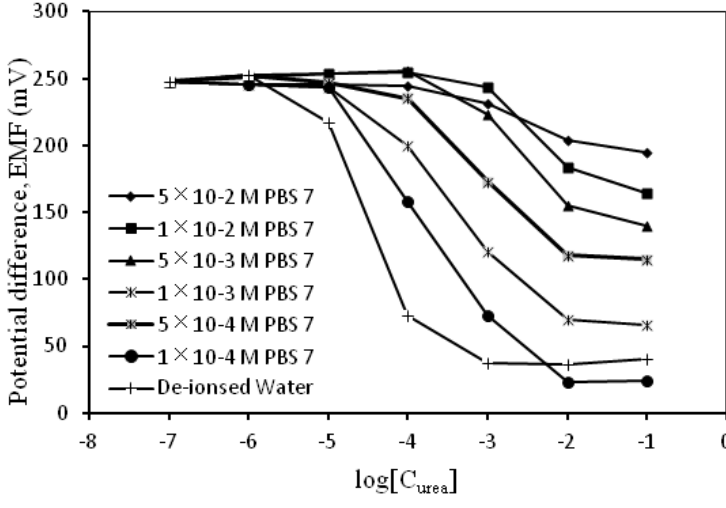
Figure 6. Effect of buffer concentration on the response of the urea